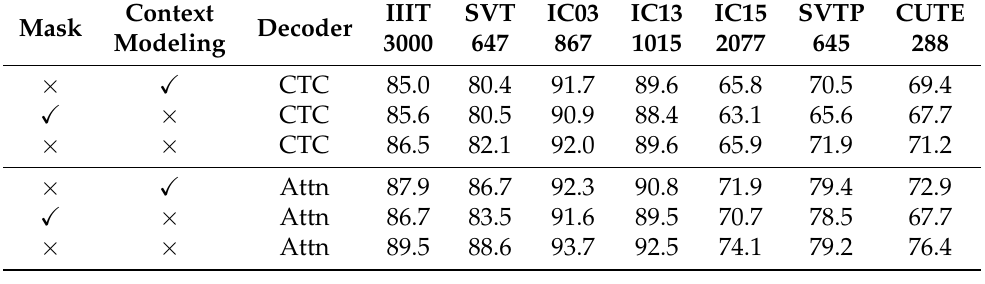
Table 2. Performance comparison with mask and context modeling module. There are two kinds of decoder, CTC and attention decoder. All models are trained on two synthetic datasets. The batch size is 896 and the training step is 300,000. The number of blocks in TFE is 6 and skip attention is not used.